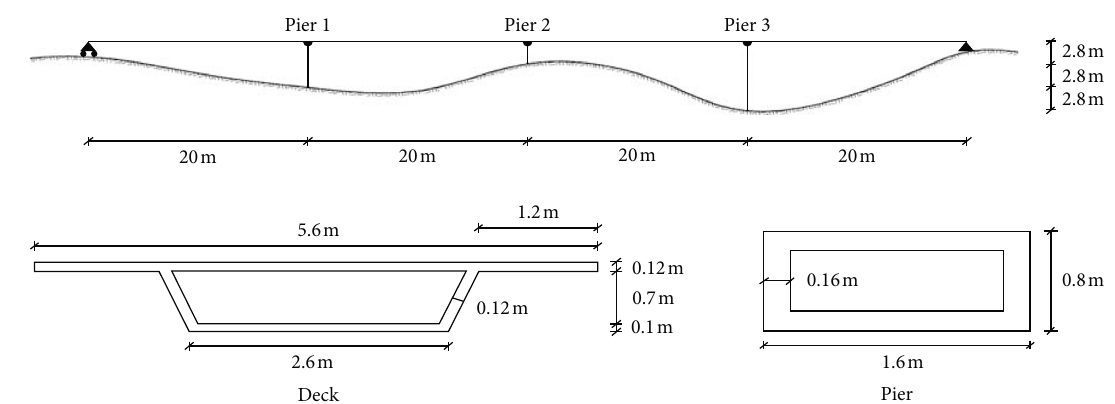
Figure 4: Longitudinal view and cross sections of b213 bridge dimensions [16], numbers 1, 2, and 3, respectively, represent short (2.8m), medium (5.6m), and tall (8.4m) piers.